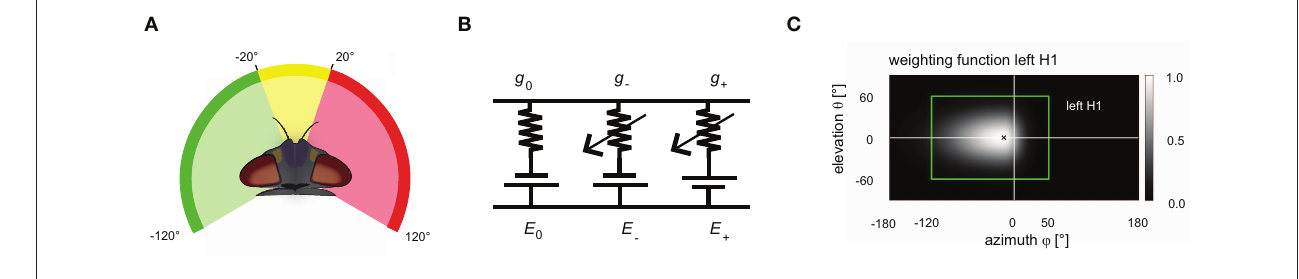
( E ) and the synaptically + − ( g ). (C) The sensitivity + −